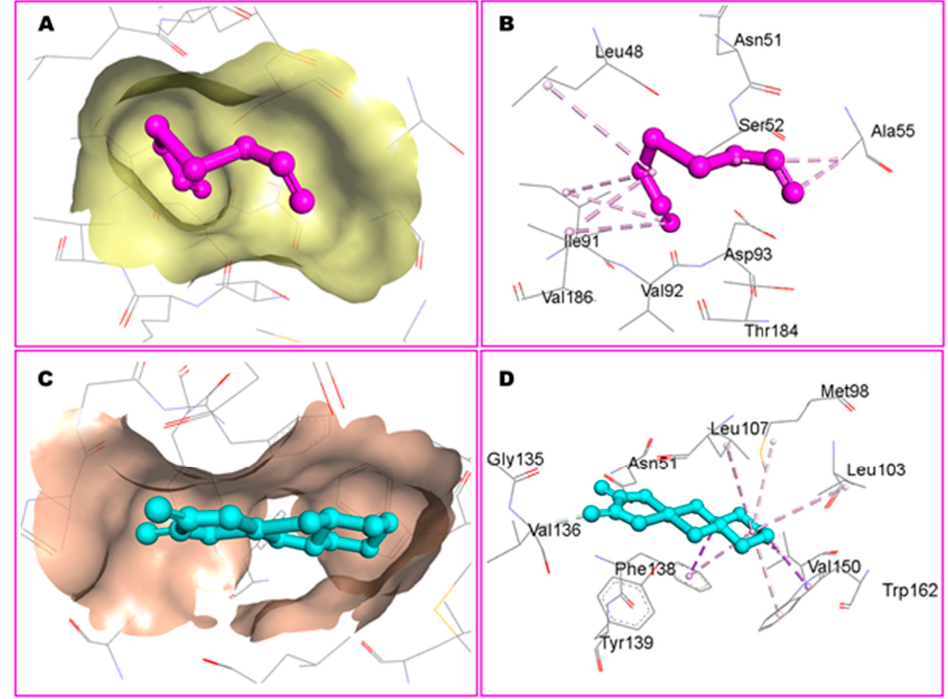
Figure 3. Binding site of Hsp90 protein (shown as surface in A , C ) accommodating docked DADS and OXA, depicted in purple and cyan color, respectively. Residues of the binding site of Hsp90 protein are shown with line styles ( B , D ).